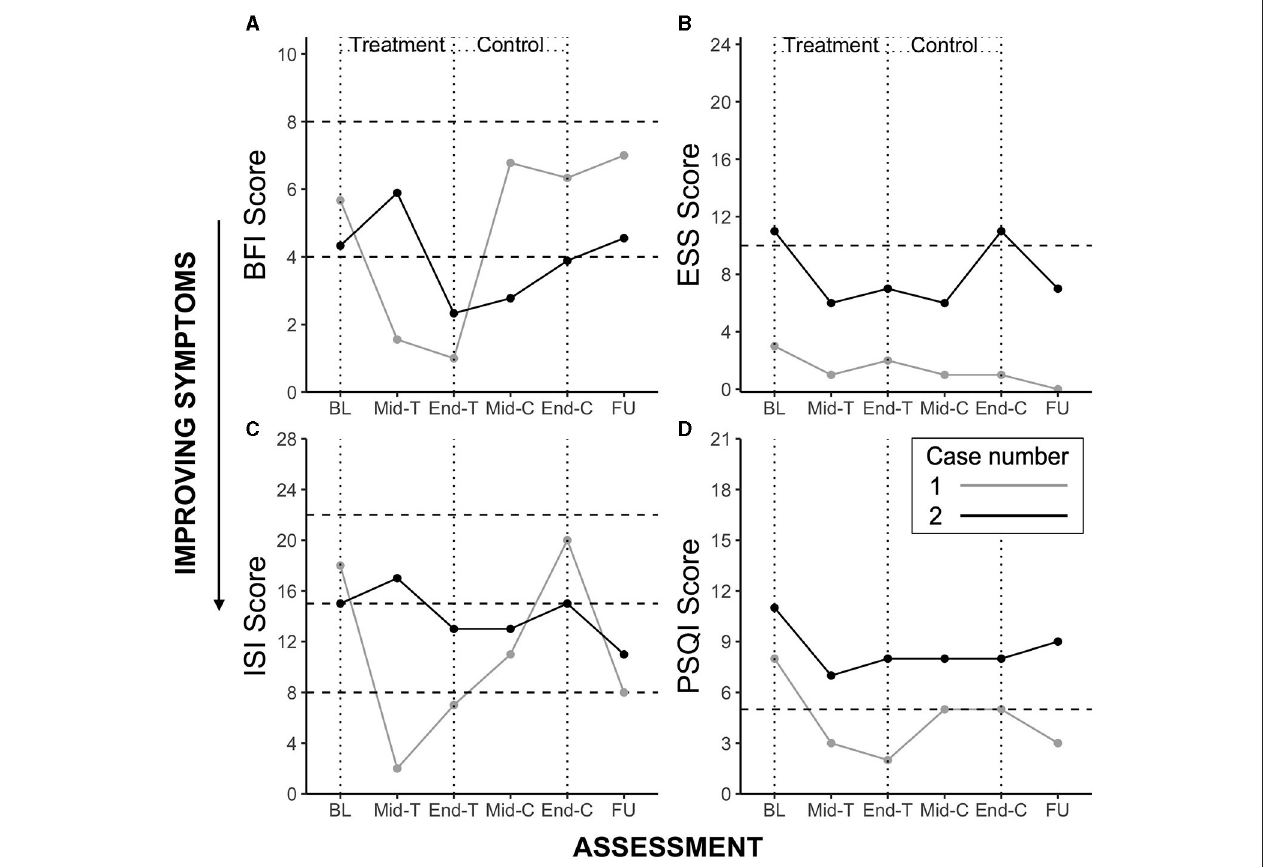
FIGURE 1 | Case study 1 and 2 outcome scores for Brief Fatigue Inventory (BFI) (A) , Epworth Sleepiness Scale (ESS) (B) , Insomnia Severity Index (ISI) (C) , and Pittsburgh Sleep Quality Index (PSQI) (D) . BL, Baseline; T, Treatment; C, Control; FU, Follow Up. Horizontal dotted lines represent clinically significant cut-offs. BFI: range 0–10, scores 4–7 represent moderate fatigue and suggest a need for intervention, scores ≥ 8 represent severe fatigue; ESS: range 0–24, score > 10 suggests clinically significant daytime sleepiness; ISI: range 0–28, a score of 8–14 indicates subthreshold insomnia, 15–21 clinically moderate, and 22 or greater severe clinical insomnia; PSQI, range 0–21, scores ≥ 5 indicate clinically significant sleep